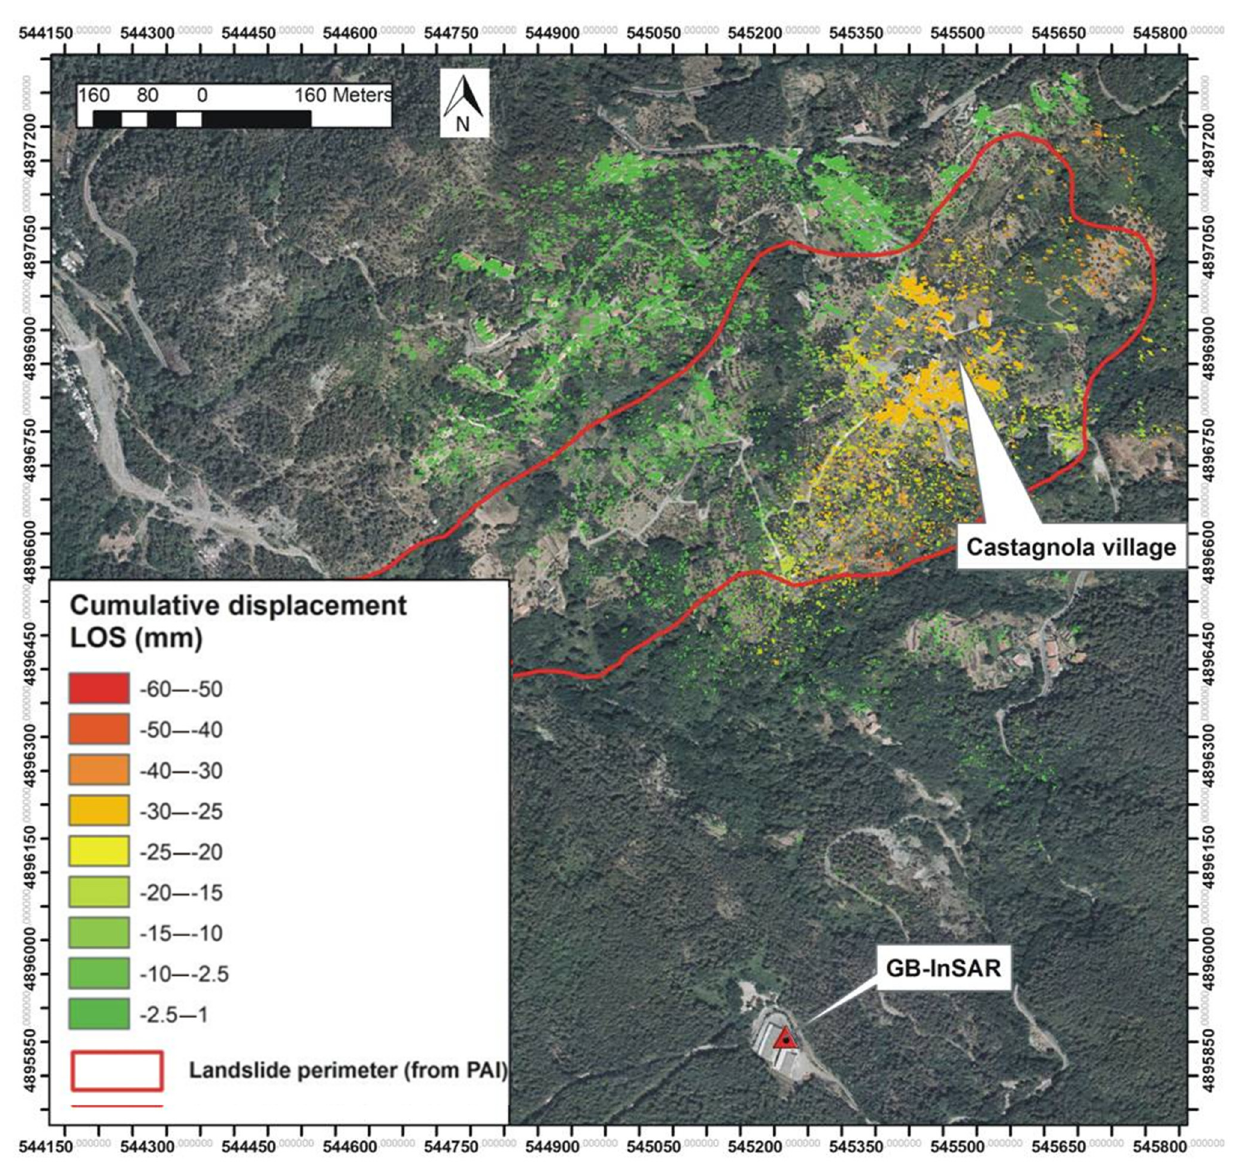
Figure 8. Cumulated displacement map of the Castagnola landslide obtained from